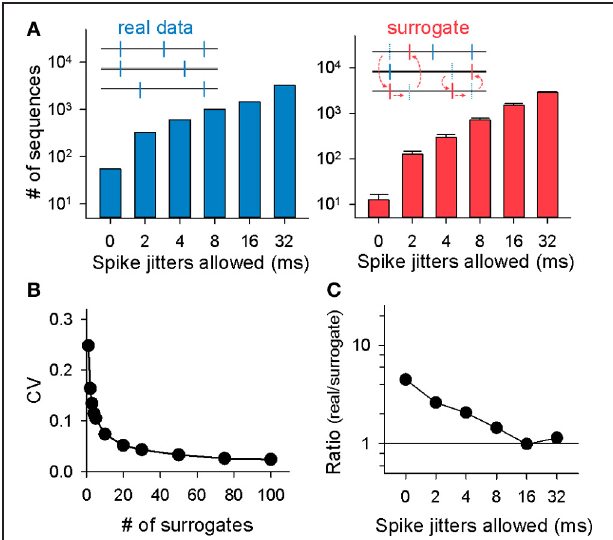
FIGURE 3 | Monte Carlo evaluation for the significance of MSSs. (A) Left : the total numbers of MSSs in the rastergram shown in (A) are plotted as a function of spike-time jitters allowed for MSS detection. Right : MSSs were identified in the same way in spike-shuffled rastergrams. Data are the mean ± SDs of 20 surrogates. (B) Relationship between the CVs of the number of MSSs detected in surrogates and the number of surrogates generated. (C) Ratios of the numbers of MSSs in the original (real) rastergram to the mean numbers of MSSs in 20 randomized surrogates. Data are the same as (B) .